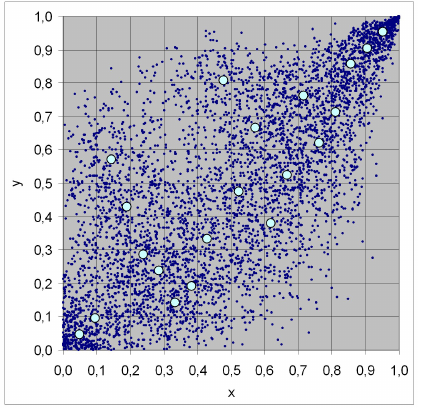
Figure 14: Asymmetric Poisson copula, a = b = 15